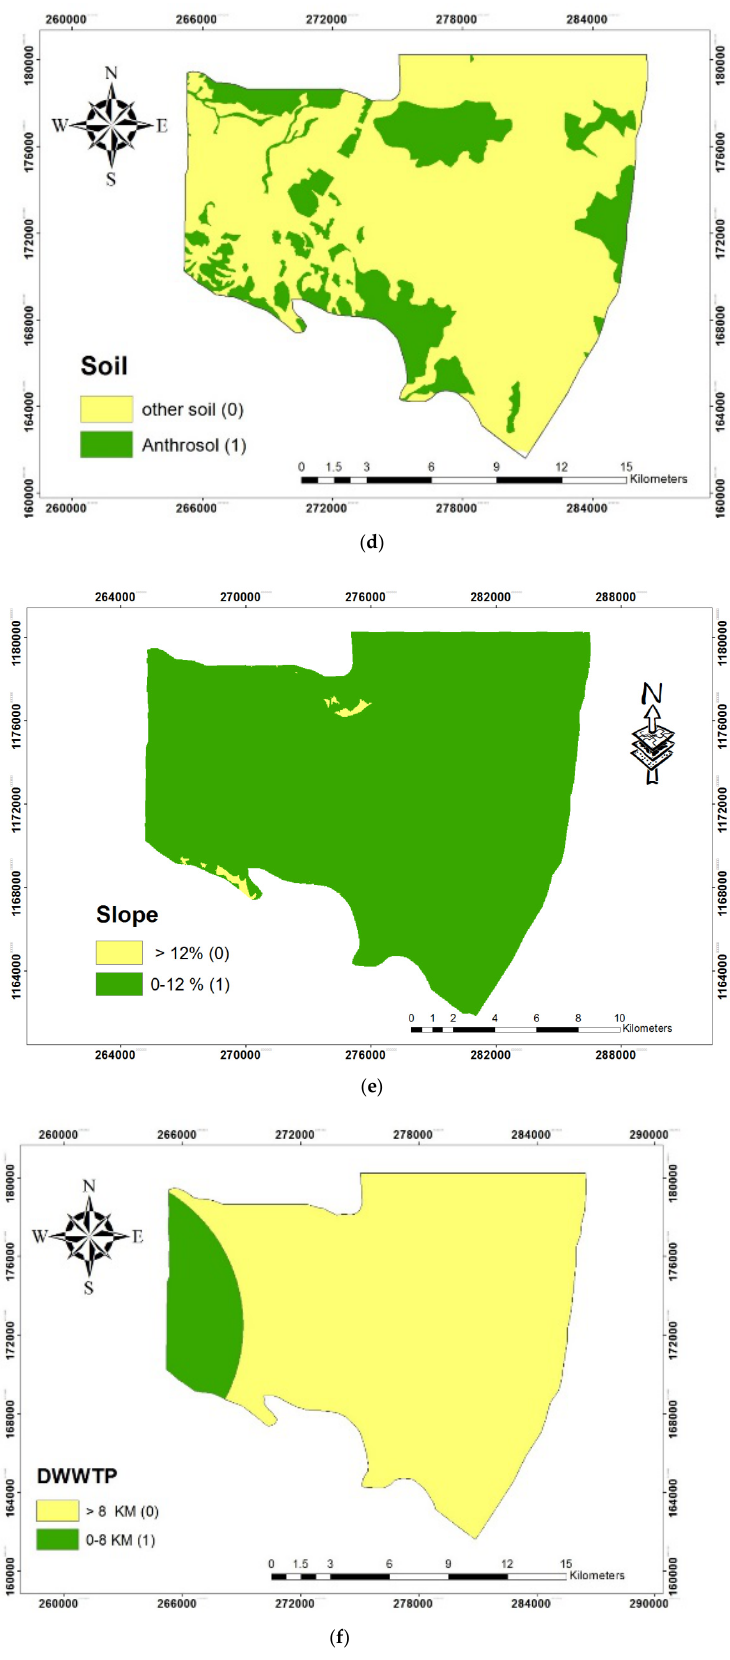
Figure 5. ( a ) Water Points thematic map. ( b ) Urban Areas thematic map. ( c ) Land Use thematic map. ( d ) Soil thematic maps. ( e ) Slope thematic map. ( f ) Distance from WWTP thematic map. The land use thematic map of the studied area was produced considering all of the bush areas (i.e., uncultivated areas) as a suitable site for recharging and coded as 1 as presented in Figure 5e. The economic criteria include an 8 km buffer zone around the four WWTPs, which are coded as 1 as shown in Figure 5f. The raster GIS maps were generated using the raster calculator to create the suitability map for the GWRC basins (Figure 6). Table 3 outlines the suitable area for GWRC and the percentage from total area based on each criterion. It was observed that water point is suitable for about 97.86% of the total land area. Up to 99.5% of the studied area, ~267.29 km 2 has the required slope, 97.97% of the studied area ~263.03 km 2 has the required urban contribution, and 97.86% of the area (262.76 km 2 ) has the right water points. However, only 55.56% of this land ( ≈ 149.19 km 2 ) has the required soil texture, and just 7.96% of the land (18.68 km 2 ) has a good opportunity in terms of close WWTP. Table 3. Selected suitable area for GWRC basins based on each criterion. Criterion